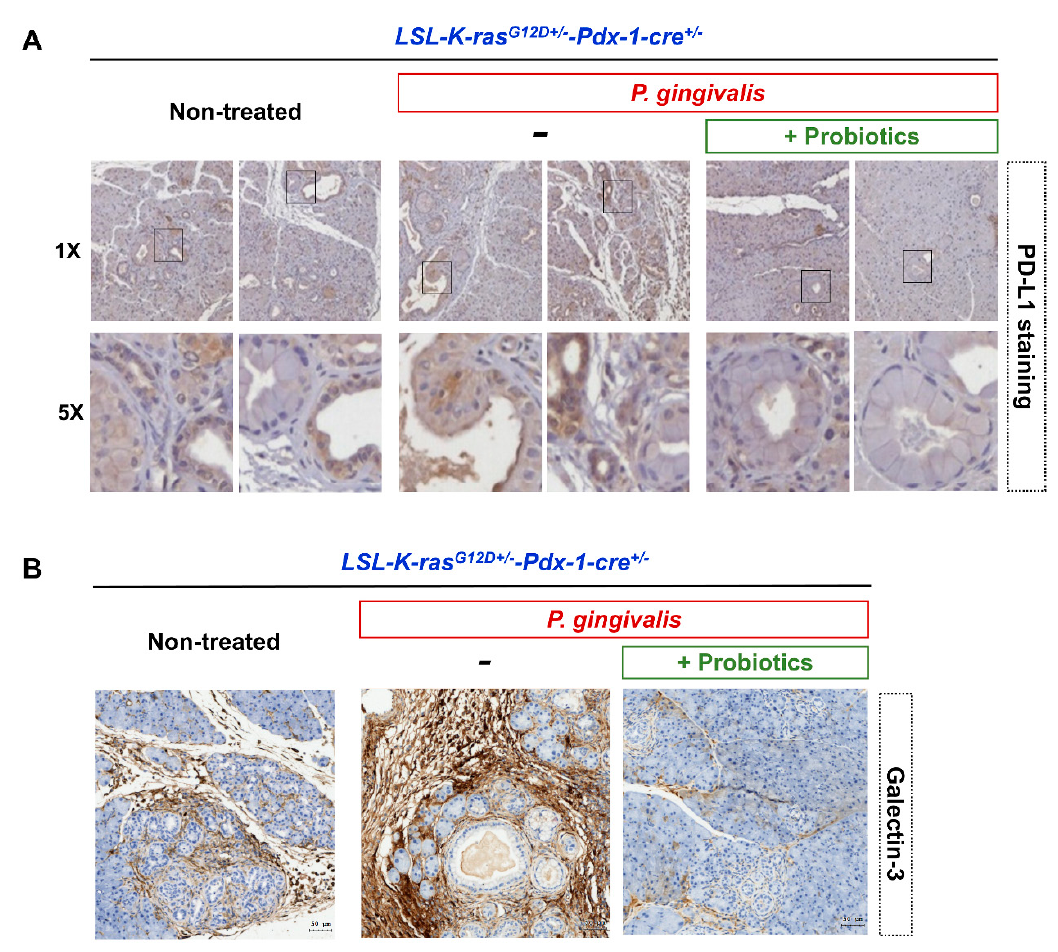
Figure 6. Representative images of immunomodulatory proteins in pancreatic tissues by immunohistochemistry analysis in non-treated KC mice, P. gingivalis -treated KC mice, and P. gingivalis plus probiotic-treated KC mice (GMNL 89: GMNL133 in 1:1 ratio). ( A ) PD-L1 staining. ( B ) Galectin-3 staining (scale bar, 50 µ m). KC, LSL-K-ras G12D +/ - - Pdx-1-cre +/ - ; PD-L1, programmed death-ligand 1.